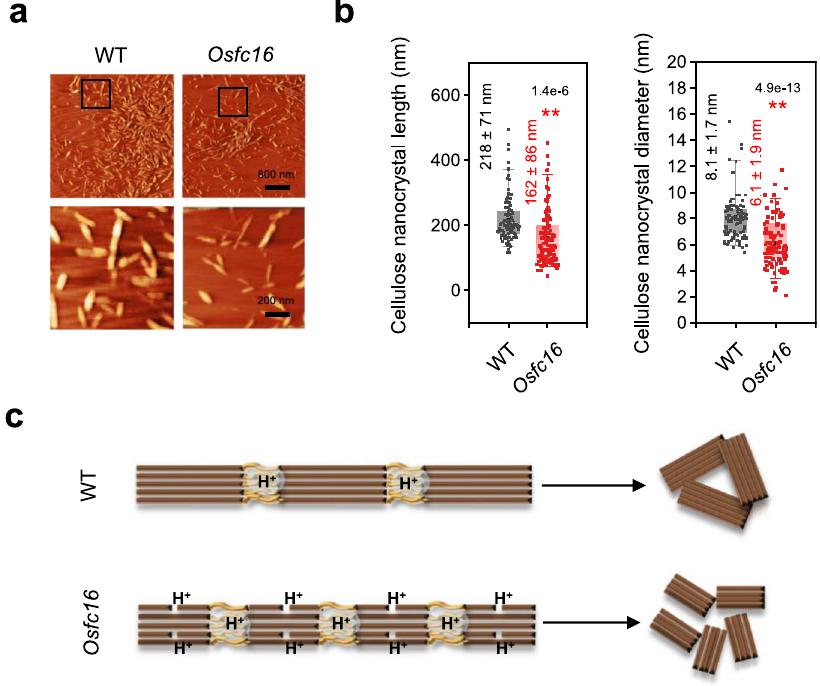
Fig. 6 | Smaller size cellulose nanocrystals and raised nanopore volumes in Osfc16 mutant.a AFMobservationofcellulosenanocrystals.Theareasintheblack boxes are magni fi ed in the lower images. b Measurement of average length and diameter of nanocrystals by randomly selecting 100 nanocrystals from three bio- logically independent samples. c Acidic catalysis modes for distinct cellulose nanocrystals. Data in b are displayed as box and whisker plots with individual data